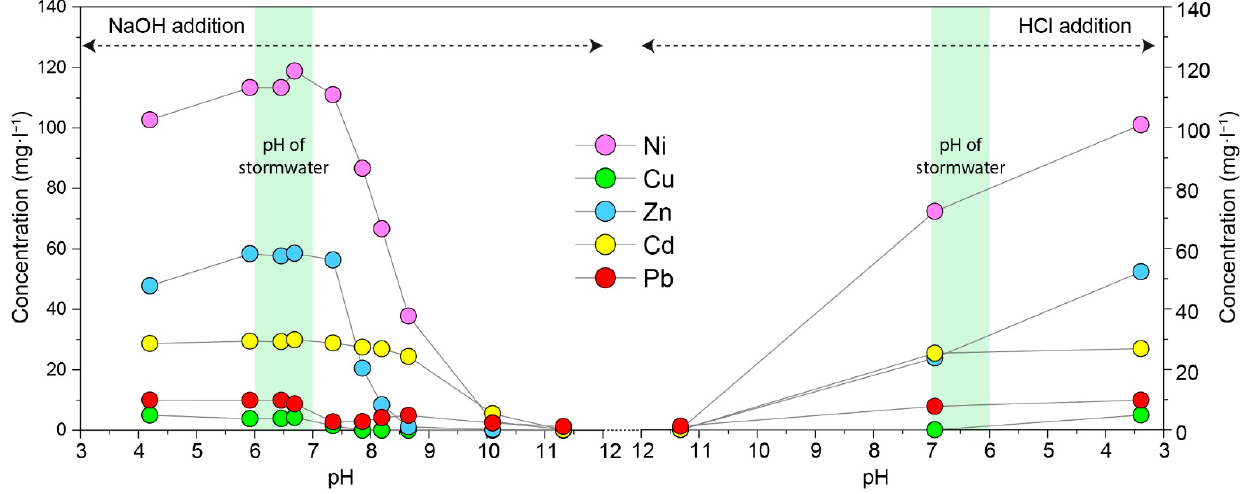
Figure 7. Changes in concentration of contaminants in the most concentrated multielemental solution due to pH variations. The pH range of stormwater is marked in the figure.